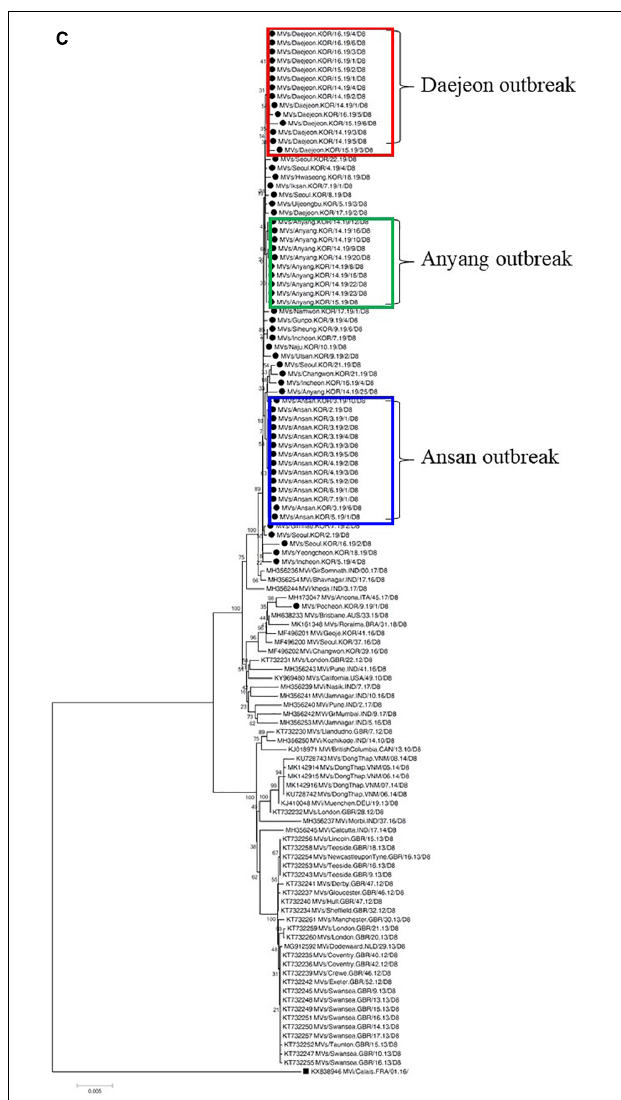
FIGURE 2 | Phylogenetic analysis of MeV genotype D8 strains based on nucleotide sequences using the neighbor-joining tree. Values on branches are shown as percentages on the basis of 1,000 bootstrap replicates. The black dot indicates the MeV genotype D8 relevant to Korean occurrences in 2019 and named strains accepted in MeaNS. The tree was rooted with respect to the genotypes D8 and B3 based on WHO and GenBank reference sequence. (A) N-450 gene analysis of MeV genotype D8. The black squares indicate the MeV genotype B3 reference using genotype D8 outgroup. (B) MF NCR gene analysis of MeV genotype D8. The black squares indicate the MeV genotype D8 reference using genotype B3 outgroup. (C) MF NCR-H gene analysis of MeV genotype D8. The black squares indicate the MeV genotype D8 reference using genotype B3 outgroup. The blue box indicates Ansan, the green box indicates Anyang, and the red box indicates Daejeon,